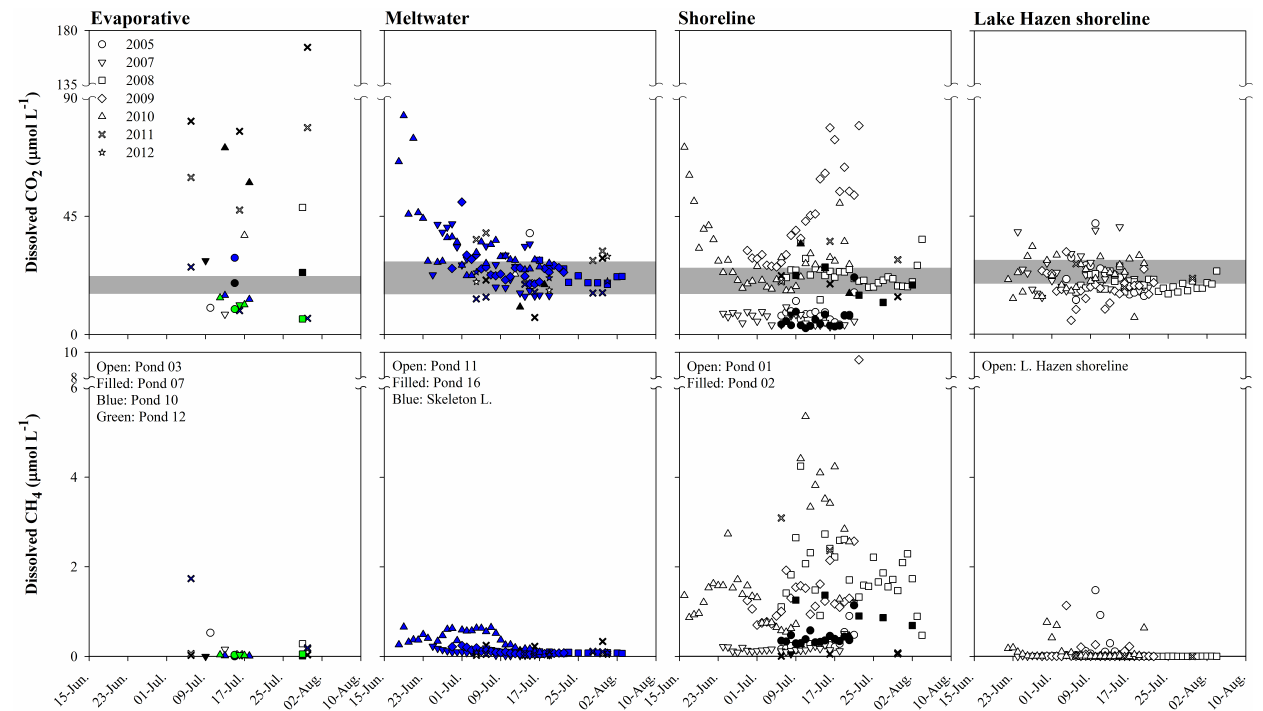
Figure 2. Dissolved carbon dioxide (CO 2 ) and methane (CH 4 ) concentrations during the 2005 and 2007–2012 growing seasons (June– August) of different types of high Arctic freshwater systems in the Lake Hazen watershed. Inset text shows site names within each freshwater type. Grey areas indicate the range of atmospheric equilibrium concentrations CO 2 and CH 4 during the sampling